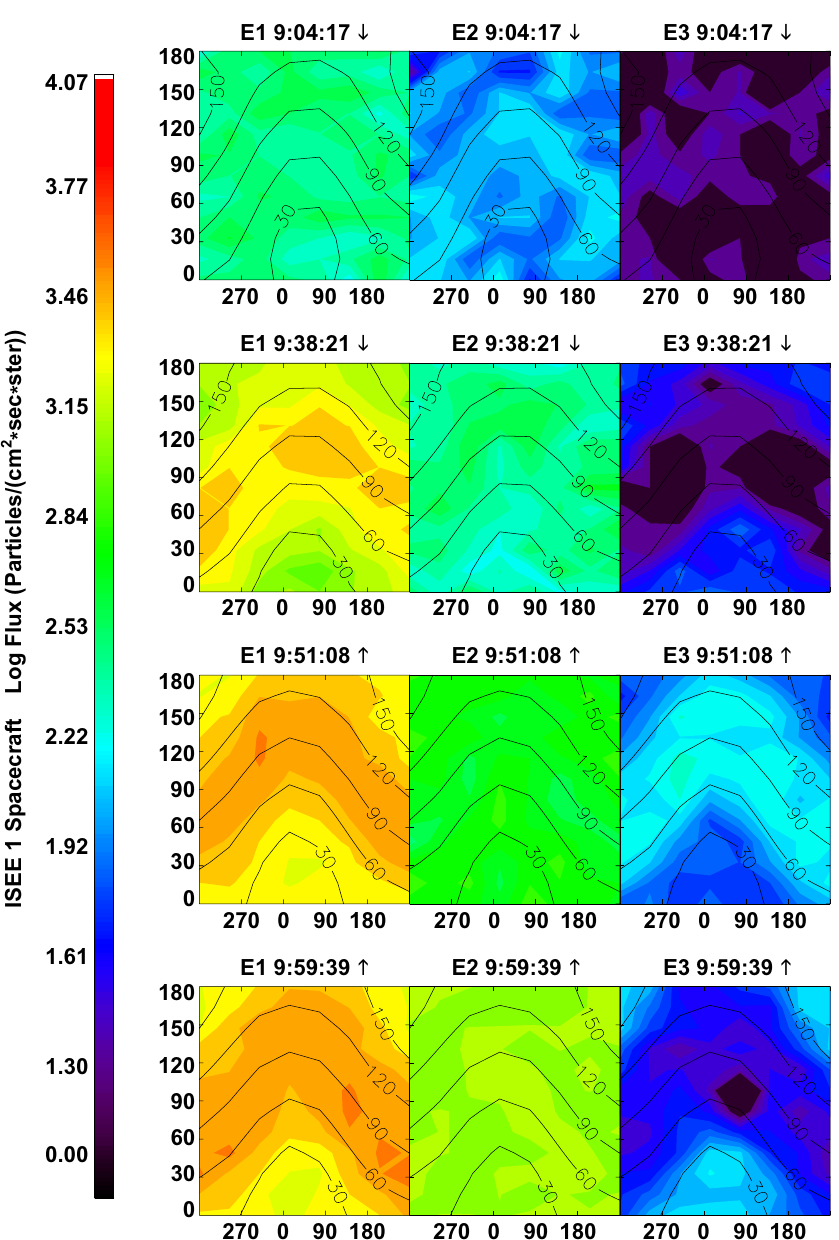
Fig. 5. The 3-D electron PADs for channels E1, E2, and E3 (three columns) at four different times (four rows for 09:04:17, 09:38:21, 09:51:08, and 09:59:39 UT,